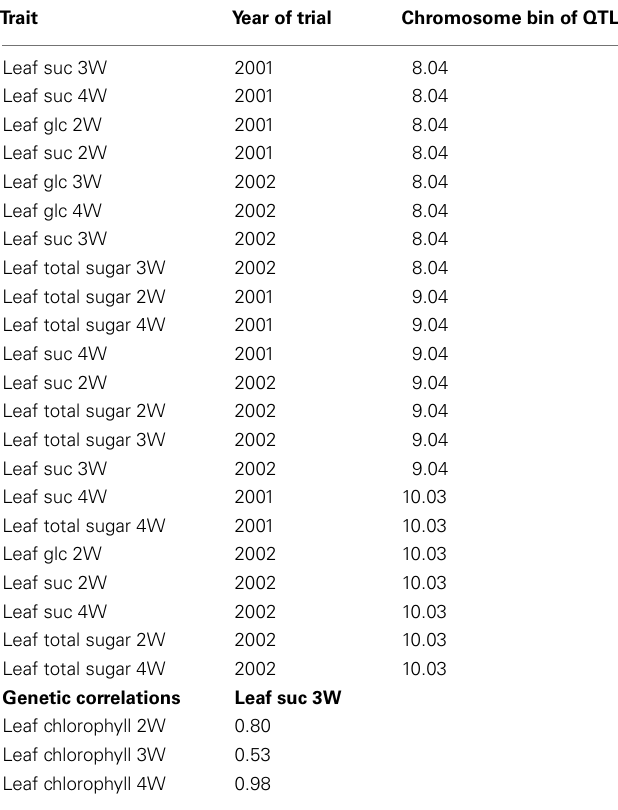
Table 4 | Upper panel: QTLs identified for leaf sugar accumulation in a maize RIL population (Cimmyt P1 X P2) subjected to severe water deficit during flowering. Lower panel: genetic correlations between leaf sucrose and leaf